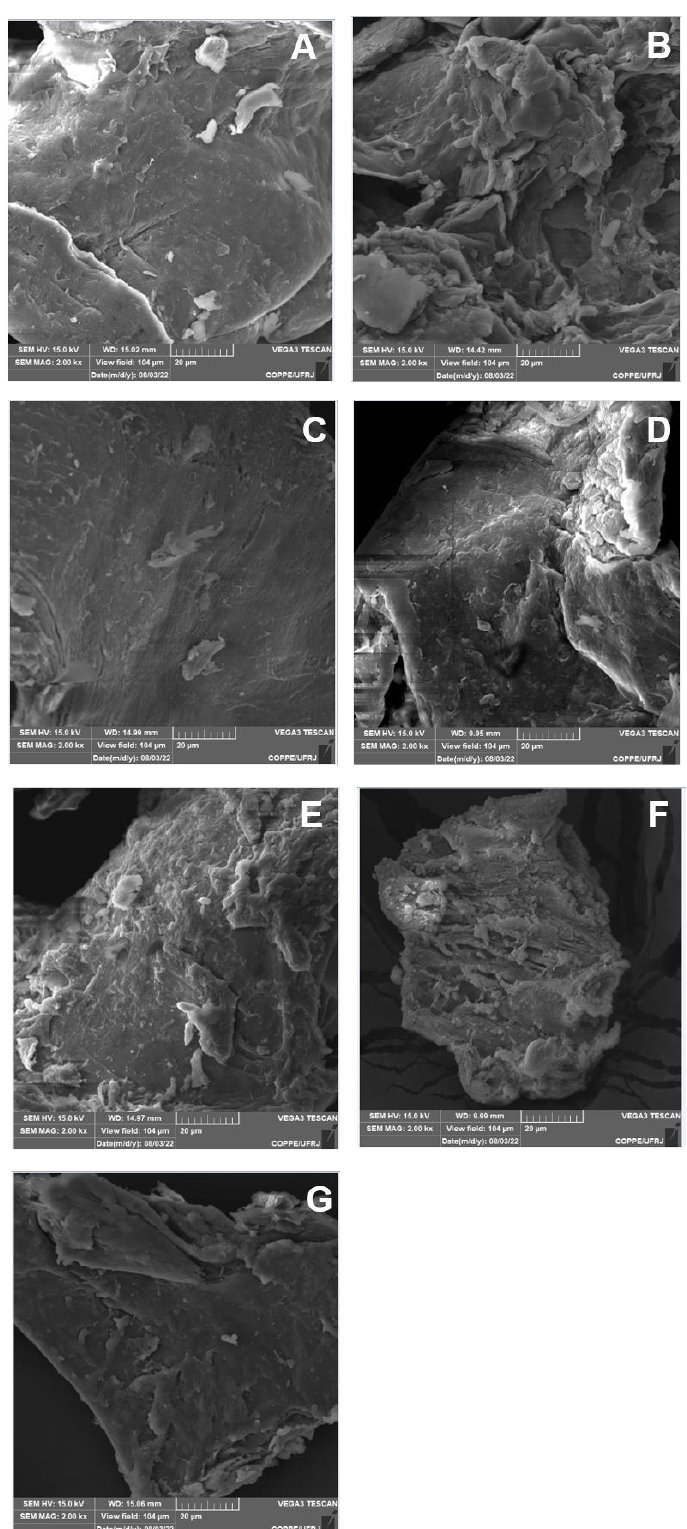
Figure 9. Morphological characterization of chitosan ( A ), 1,4-NQ-CS obtained following the EtOH:H 2 O method ( B ), 1,4-NQ-CS following the EtOH:H 2 O + Et 3 N method ( C ), 1,4-NQ-CS fol- lowing the DMF method ( D ), 1,2-NQ-CS following the EtOH:H 2 O method ( E ), 1,2-NQ-CS following the EtOH:H 2 O + Et 3 N method ( F ), 1,2-NQ-CS following the DMF method ( G ), the structural ultra- photographies were acquired at 15 kV and 2000 ×